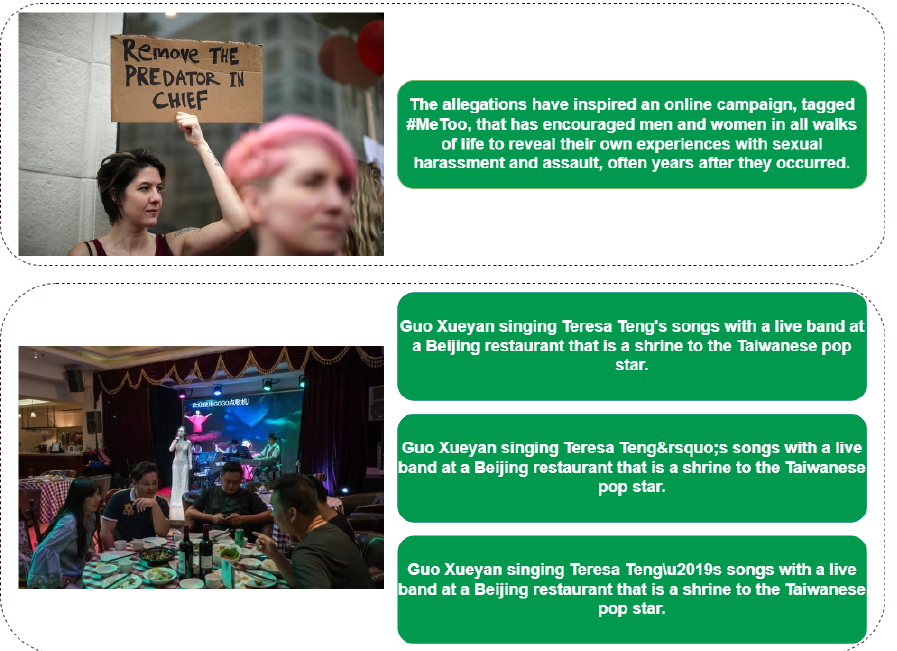
Figure 2. Example of the captioned image in the training set. Training data do not contain an out-of-context captioned image. Every captioned image is not-out-of-context and does not have a context